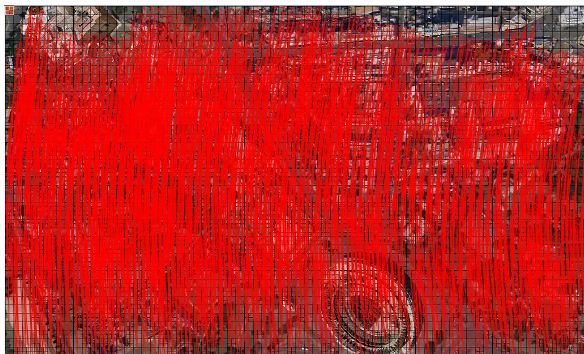
Figure 3: An example of correct motion estimation initialized by a sensor aided global motion estimation. The analyzed video is the same of Figure